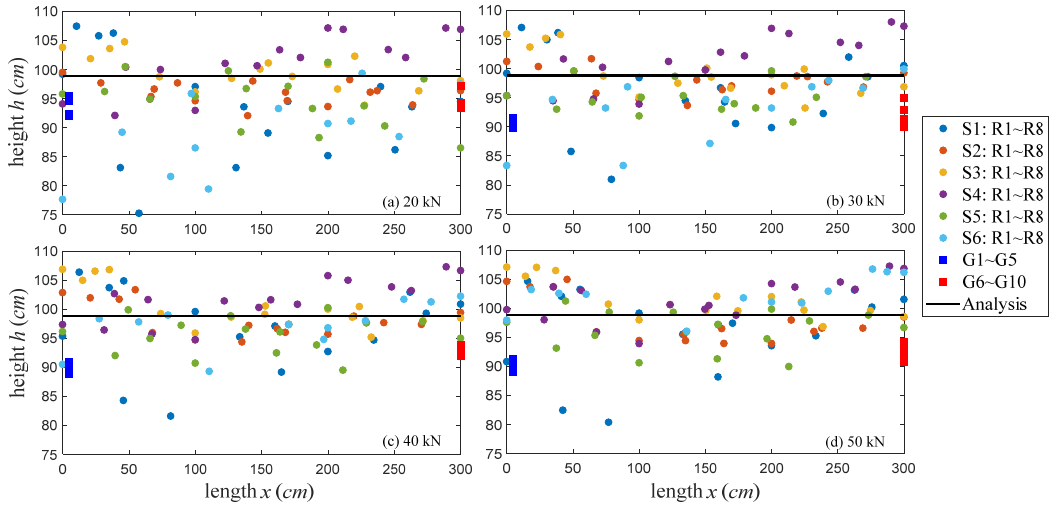
Figure 12. All the neutral axis locations determined by ultrasonic transducers, gauge gauges, and structural analysis. ( a ) The neutral axis locations at 20 kN; ( b ). The neutral axis locations at 30 kN; ( c ) the neutral axis locations at 40 kN, and ( d ). The neutral axis locations at 50 kN.